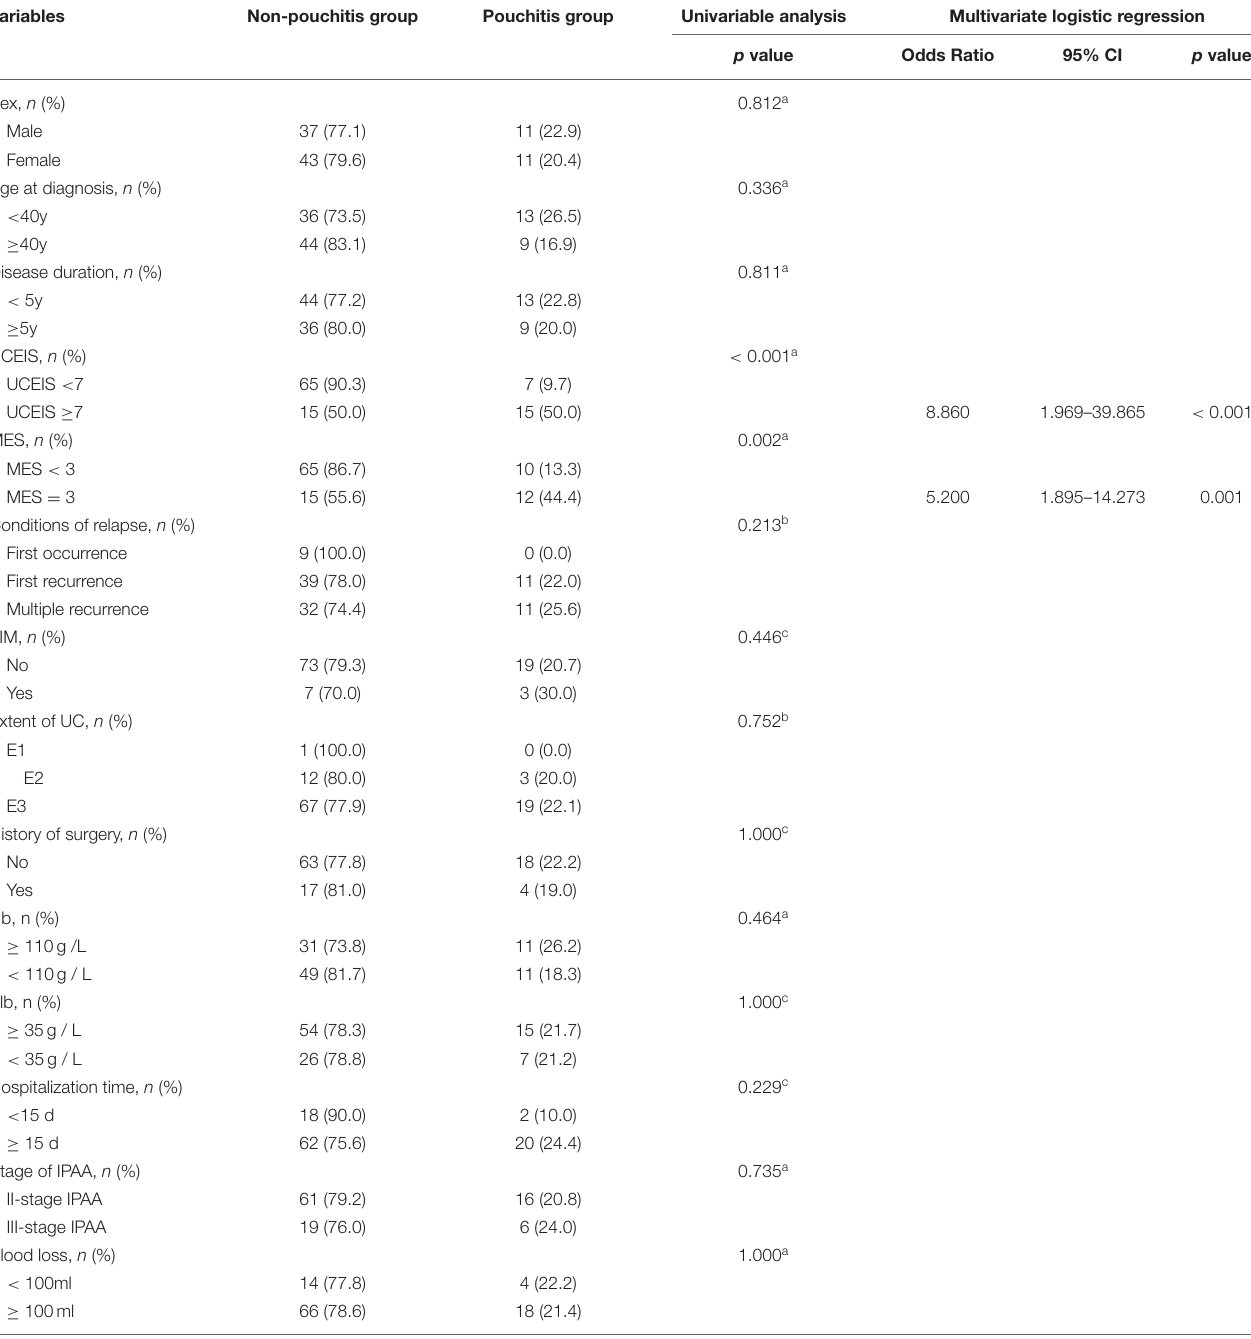
TABLE 4 | Univariable and multivariate analysis of risk factors for pouchitis after IPAA in UC.